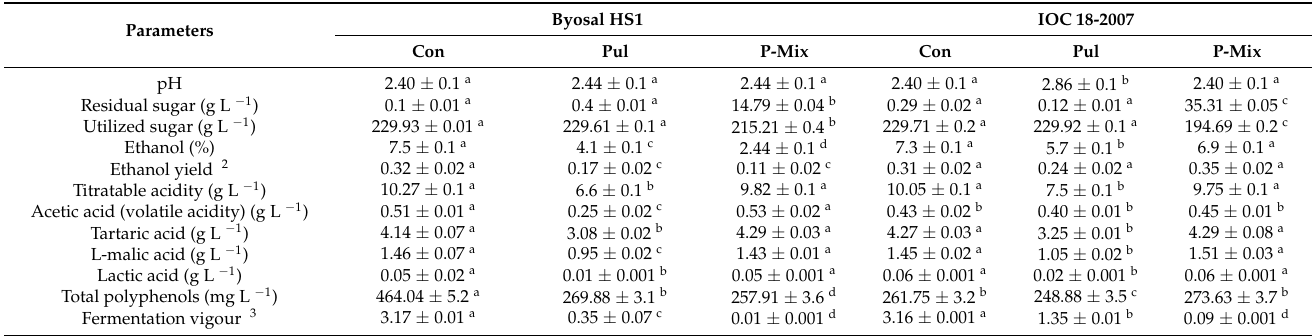
Table 2. Enological performance of Saccharomyces cerevisiae strains Byosal HS1 and IOC 18-2007 grown on synthetic must (Con) and synthetic must amended with 10 µ g mL − 1 of pullulan (Pul) or pentaketides mix (scytalone/isosclerone; 9:1/ w / w ; P-Mx) 1 . Byosal Parameters